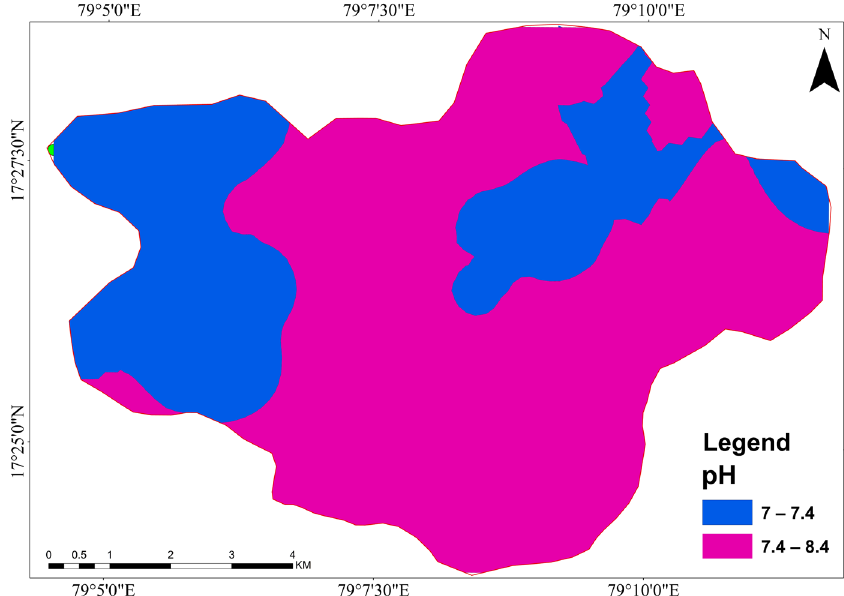
Fig. 2 Spatial Distribution map of pH in Mothkur region, Telan- gana State, South